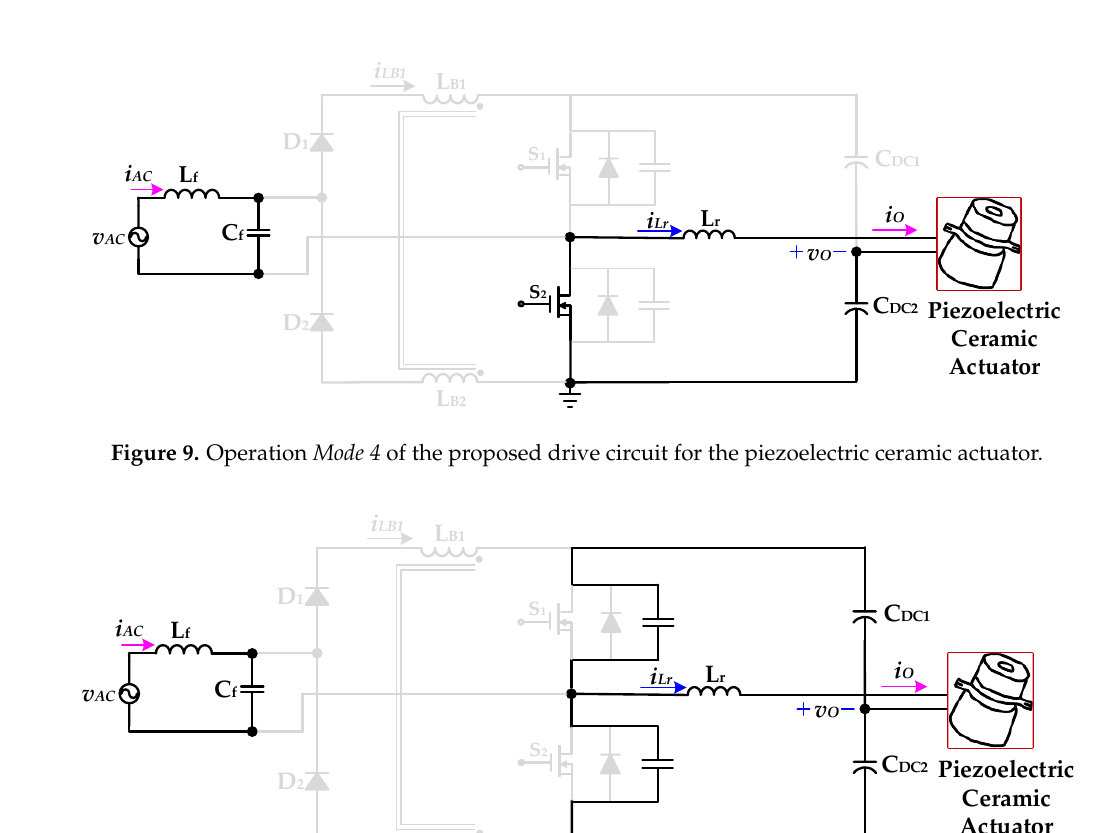
i Lr Figure 8. Operation Mode 3 of the proposed drive circuit for the piezoelectric ceramic actuator.